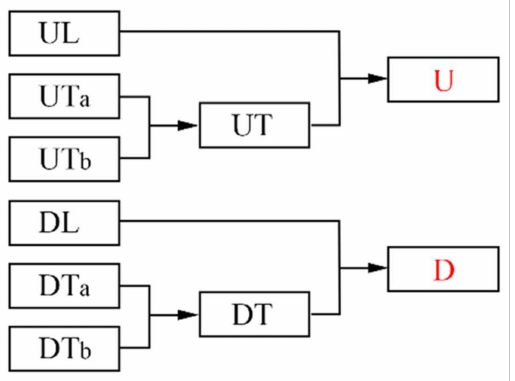
Figure 19. The schematic diagram of vortex evolution in U-D mode.